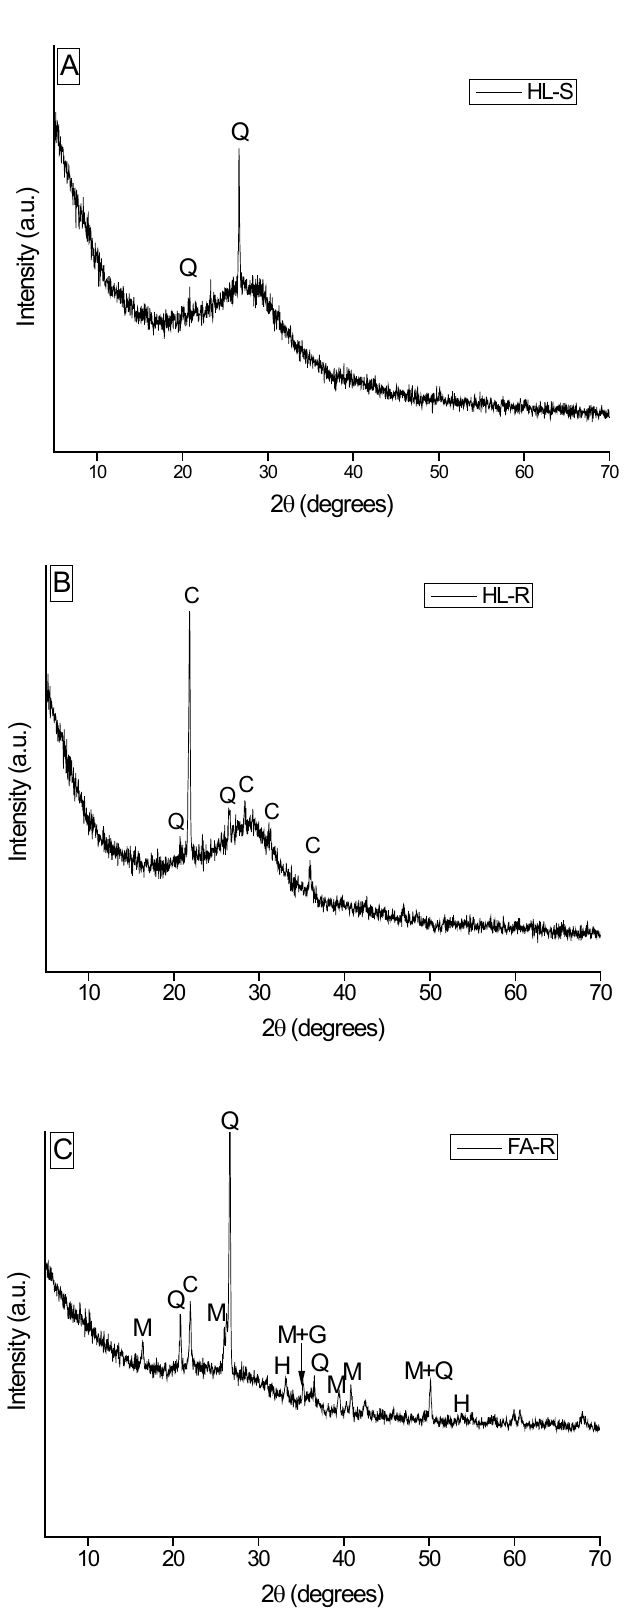
Figure 5. XRD patterns of geopolymers: ( A ) HL-S; ( B ) HL-R; ( C ) FA-R. (C = Cristobalite, Q = Quartz, G = magnetite, M = mullite).